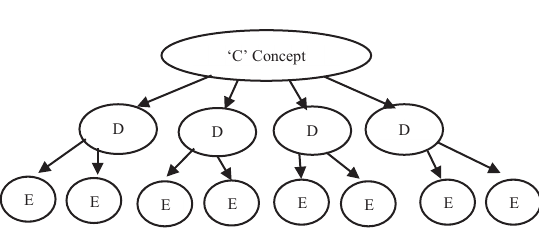
Figure 1. The concept of